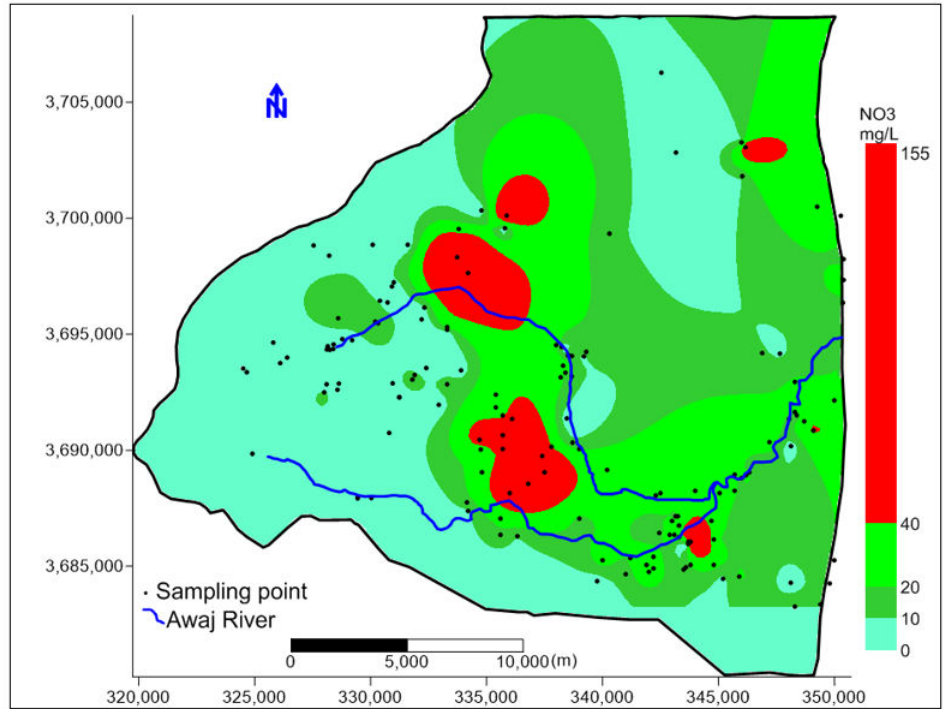
Figure 14. Spatial distribution of NO 3 − (mg L − 1 ) values measured in the groundwater samples, December 2006.